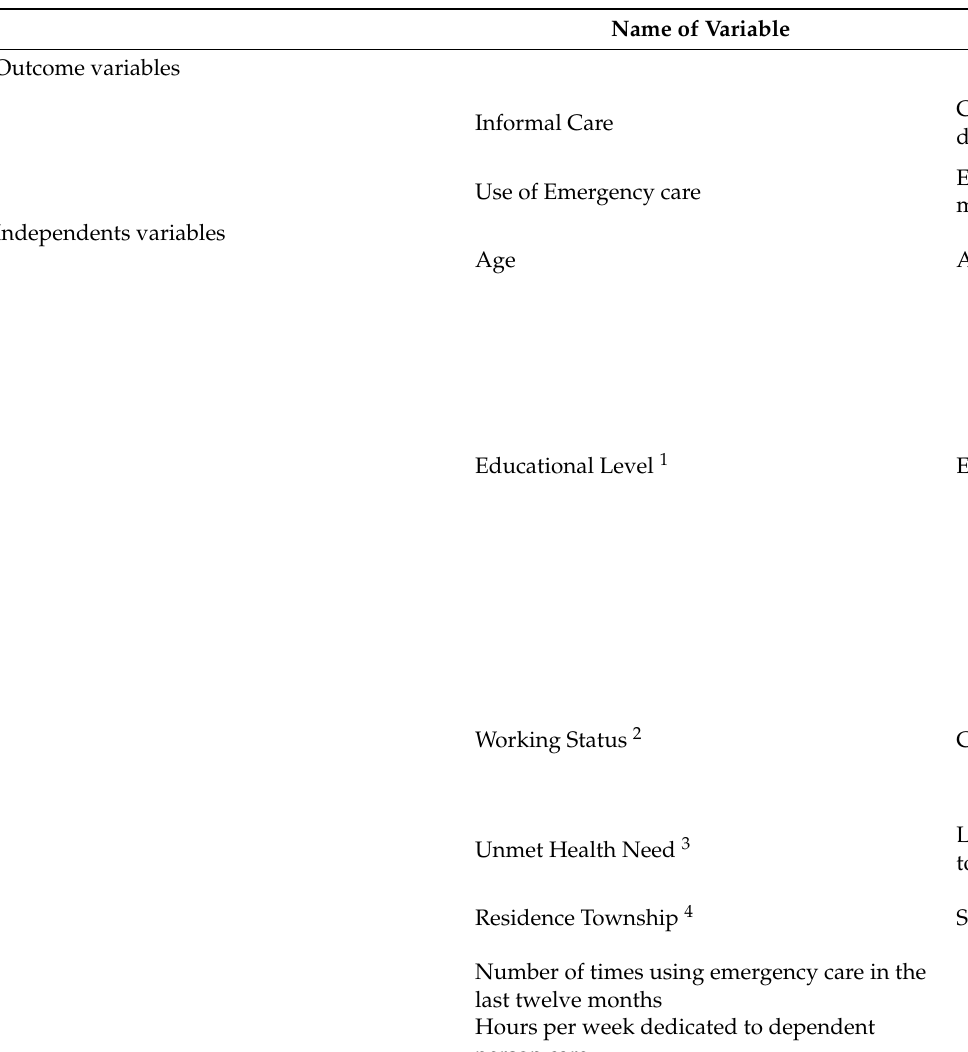
Table 1. Definition of the variables used in the